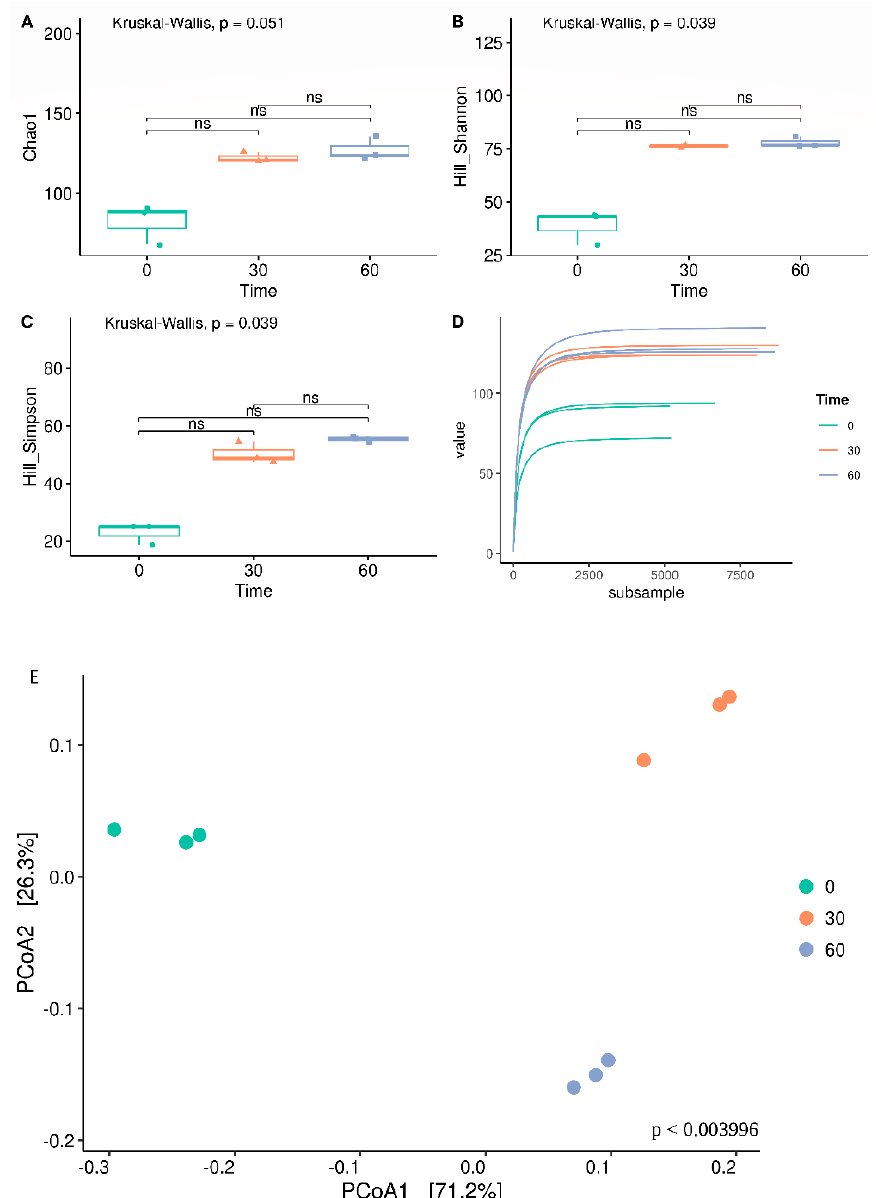
Figure 3. α and β diversity of SMS incubation. Chao1 index ( A ) Hill–Shannon ( B ) Hill–Simpson index ( C ), each calculated after rarefaction to a coverage of 99.5%, and rarefaction curves of observed species of bacterial community composition ( D ). Box and whiskers represent the minimum (Q 0 ), 1st quartile (Q 1 ), median (Q 2 ), 3rd quartile (Q 3 ), and maximum (Q 4 ) of each group. Reported p -value is